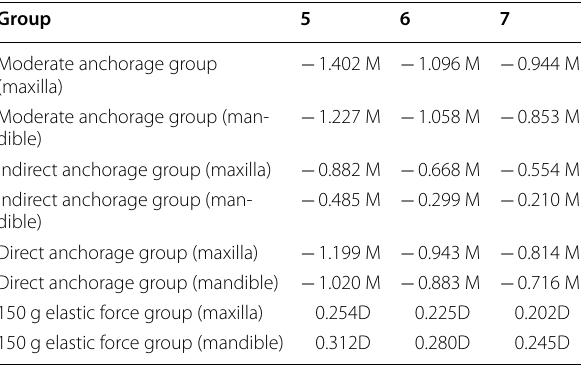
Table 6 Mesial/distal movement value of the posterior tooth